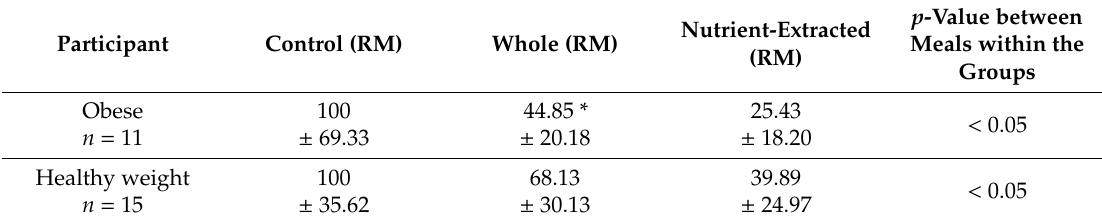
Table 2. Mean glycemic index ± standard deviation for raspberry-mango (RM).